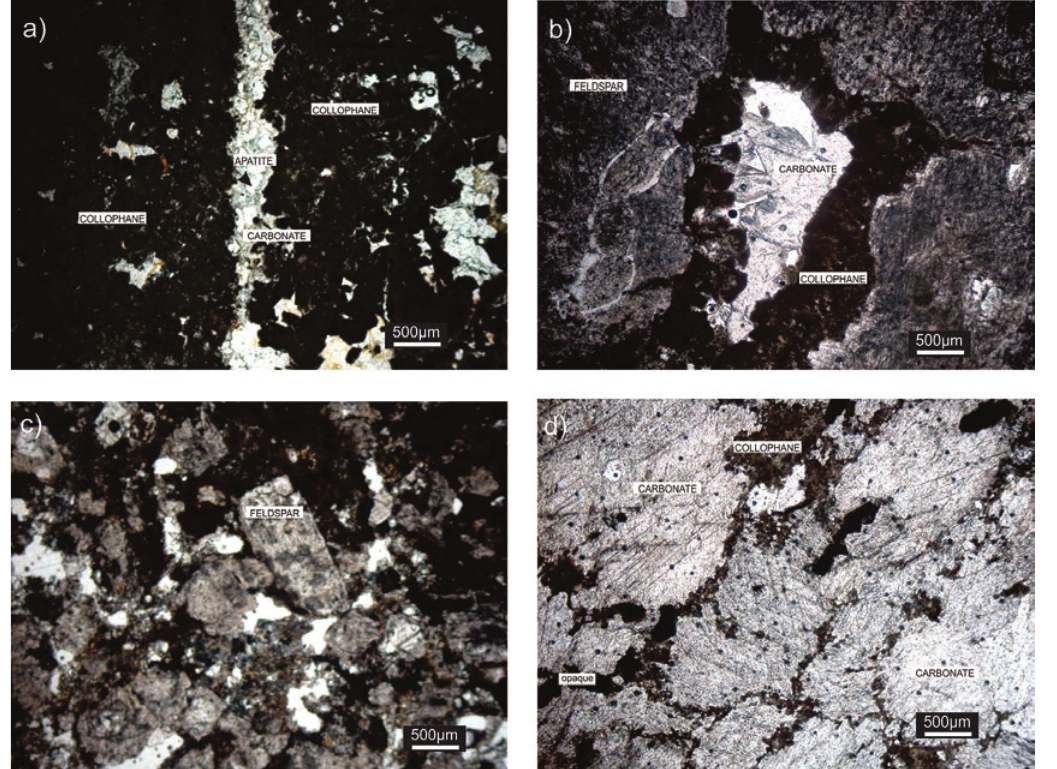
Figure 10 - Photomicrographs of the main ore types of Itataia U-P deposit: a) collophanite; b) episyenite; c) carbonaceous breccia; and d) disseminated collophanite in